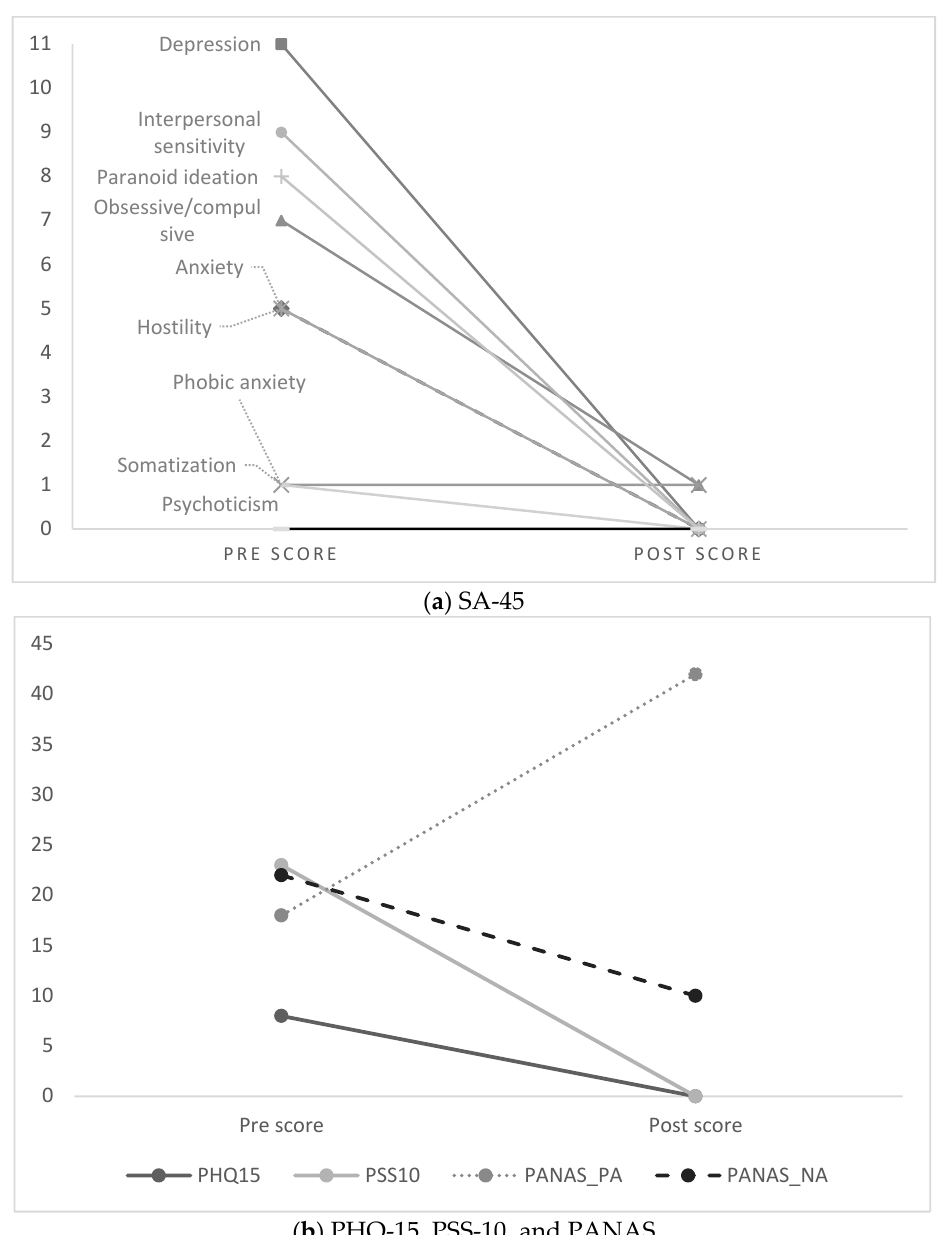
Figure 1. Pre- and post-treatment scores on psychological symptoms, somatic symptoms, stress, and affective states. Note: Pre- and post-treatment scores on ( a ) the 9 psychological symptom domains of the SA-45 = Symptom Assessment-45, and ( b ) the PHQ-15 = Patient Health Questionnaire-15, the PSS-10 = Perceived Stress Scale, and the PANAS = Positive And Negative Affect Schedule. Higher scores indicate higher severity of symptoms, except for PANAS positive affect.